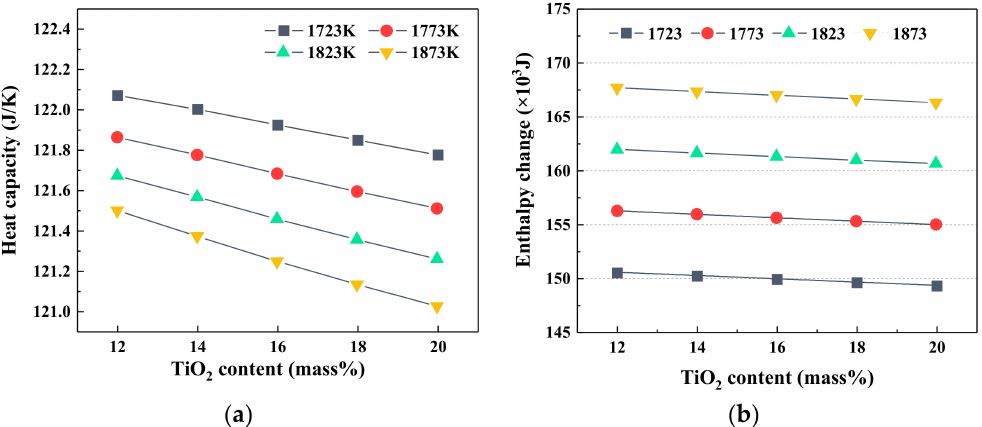
Figure 4. The heat capacity and enthalpy change of slag with varying TiO 2 contents; ( a ) heat capacity; ( b ) enthalpy